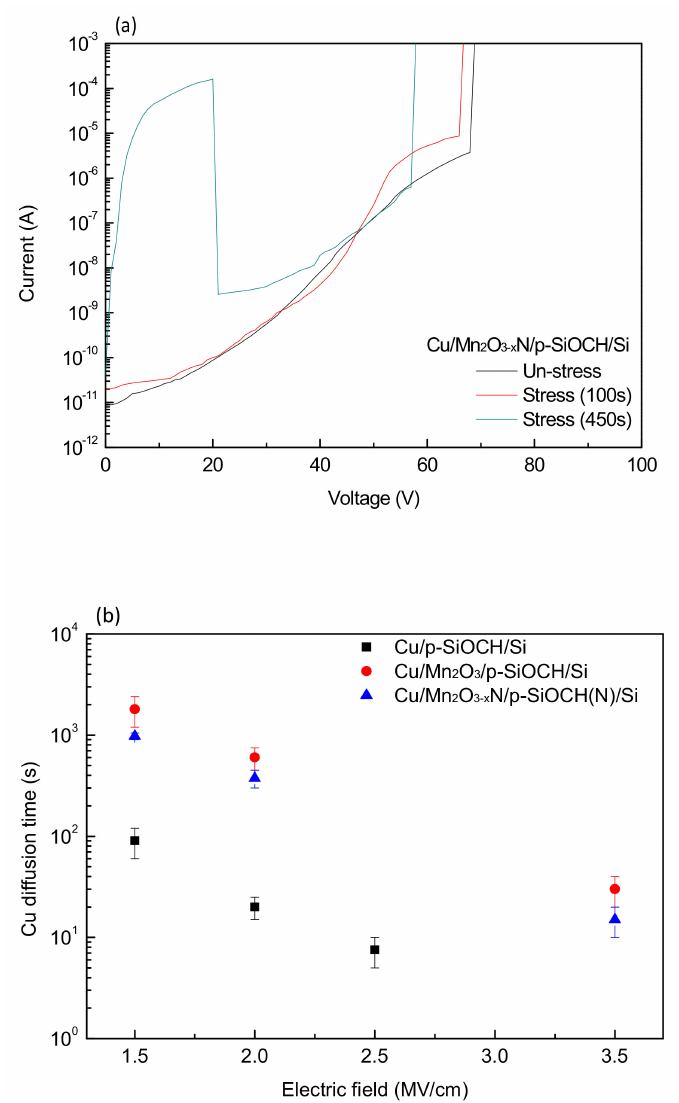
Figure 6. ( a ) I-V curves of Cu-gate an MIS capacitor with a Mn 2 O 3 − x N barrier before and after electrical stress (2.0 MV / cm) for various times; ( b ) Cu di ff usion time of various Cu-gate MIS capacitors under electrical stress as a function of the